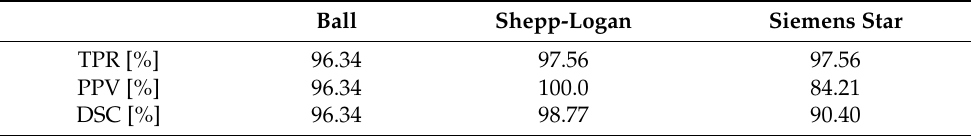
Table 1. Proposed HRA detection scheme accuracy—evaluated for synthetic data.